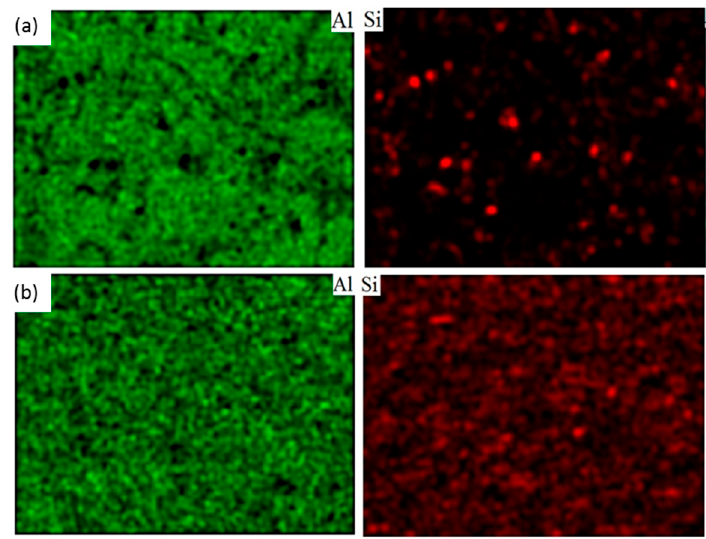
Figure 4. Energy dispersive X-ray spectroscopy (EDX) analysis of consolidated samples with milling time ( a ) 5 h and ( b ) 20 h of milling.